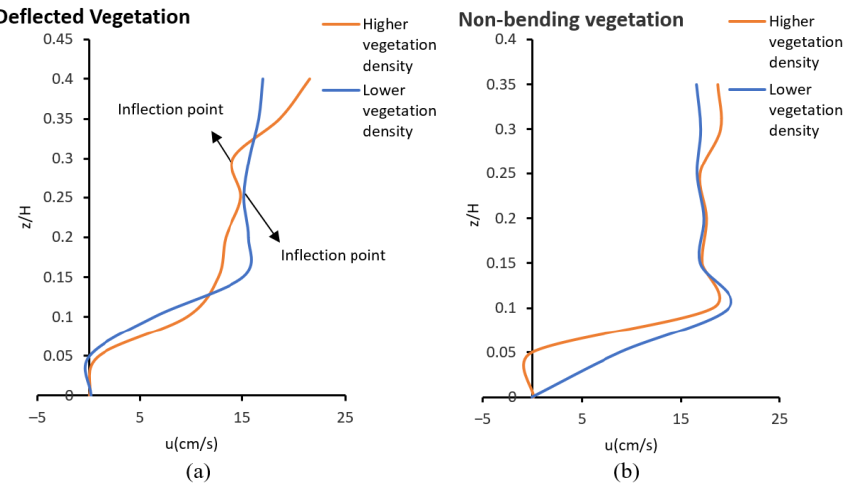
Figure 7. Velocity profiles with high vegetation density (a = 0.624 m − 1 ) and lower vegetation density (a = 0.256 m − 1 ): ( a ) deflected vegetation; ( b ) non-bending vegetation (water depth: 20 cm and square arrangement of vegetation in the wake behind vegetation (black circles in Figure 4).